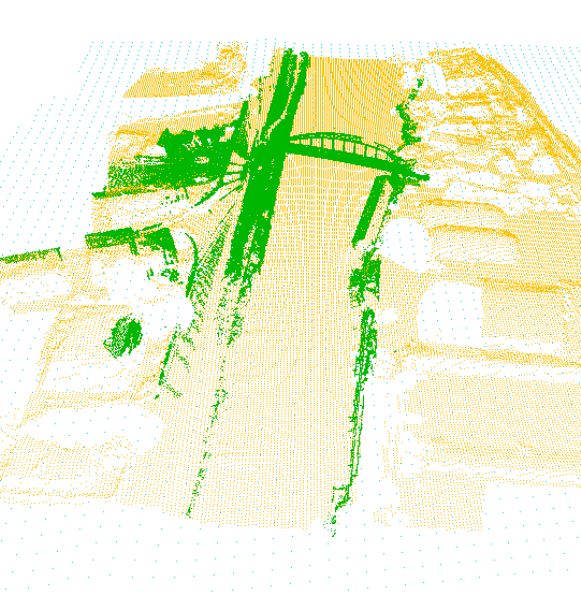
Figure 2. Data fusion from the TLS points (green) and LiDAR points from an airborne survey (orange) The part of the area which is of most interest in this study case from the northern bank of the river. The area which is processed areas in its northern part.